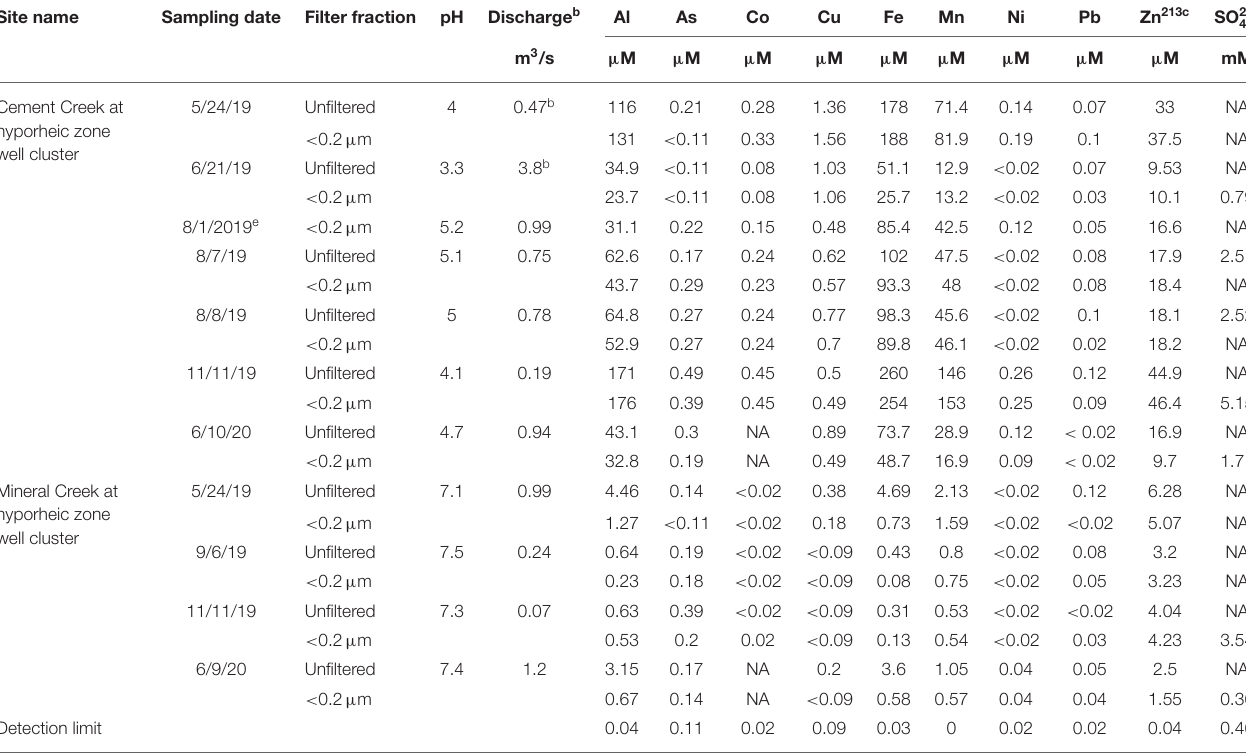
TABLE 3 | Stream chemistry for the samples collected in 2019 adjacent to the hyporheic zone well clusters and used in CQ analysis a . Site